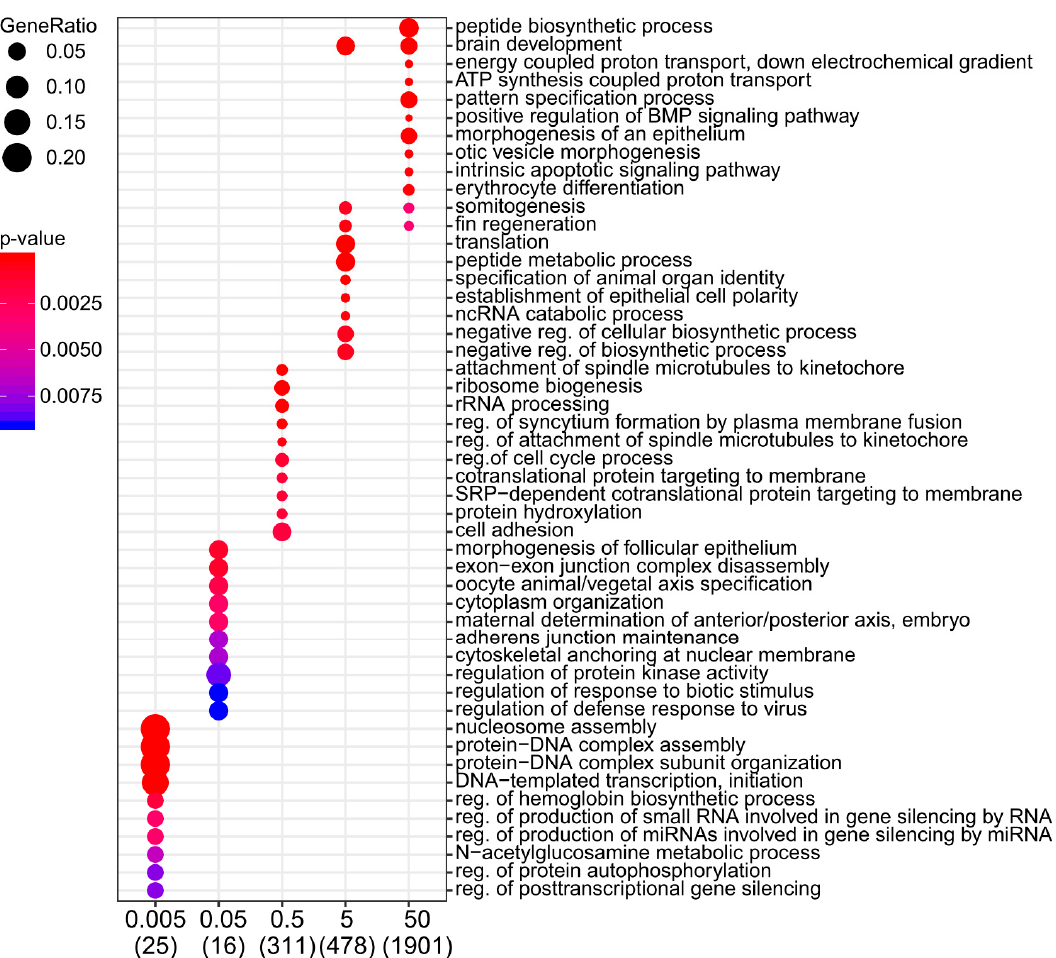
Figure 2. Dot plot of zebrafish GO (Gene Ontology) term enrichment showing the top 10 enriched pathways. Dose rates are indicated at the bottom in mGy / h. The total number of deregulated genes within the GO pathways selected on the dot plot are indicated in brackets. Colours indicate the p -values from Fisher’s exact test, and dots size is proportional to the number of differentially expressed genes (DEG) in the given pathway.